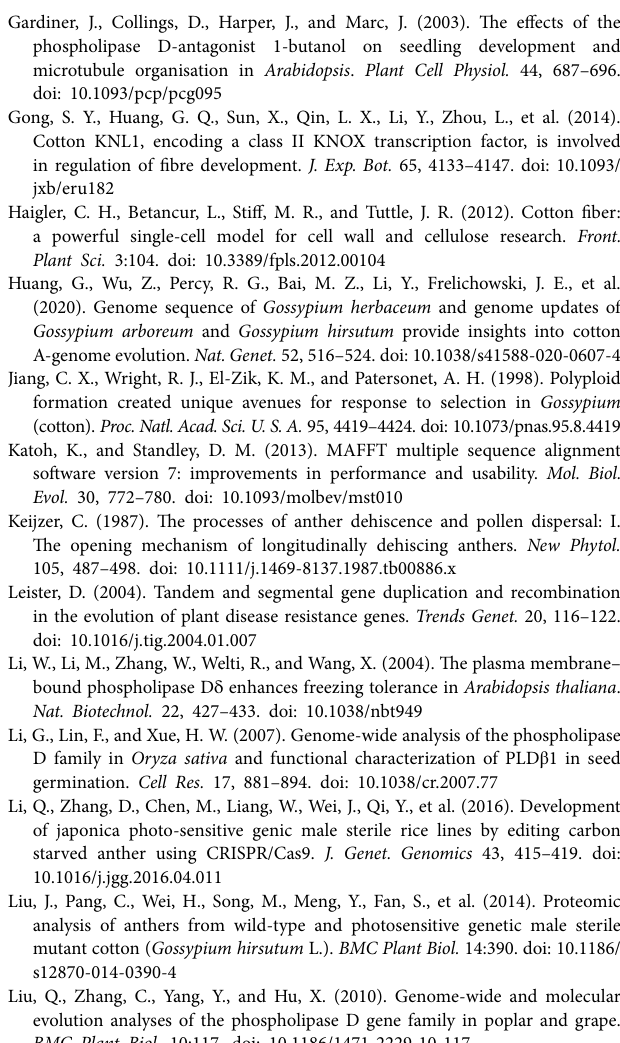
biological repeats. The values are presented as the mean ± SDs of the three replicates. Value of p was calculated based on the Student’s t -tests. Supplementary Figure S5 | Differential expression profiles of the GhPLD s in W10 (WT) and psm5 . The first stage A is a binuclear period of the microspore, the early flowering stage (flower bud length, ~10 mm). The second stage B is 1 day before flowering. The values are presented as the mean ± SDs of three replicates. Values of p were calculated using the Student’s t -tests. ** denotes significance at p < 0.01 as compared to the WT. The details of the primer sequences are listed in Supplementary Table S3 . Supplementary Figure S6 | Re-validation of subcellular localization of GhPLD2 in tobacco ( Nicotiana benthamiana ) leaves. The results in Figure 3 were re-confirmed using the lipid dye FM4-64 (Marker) which labels the cell membranes. Scale bar = 50 μ m. Supplementary Figure S7 | Model of GhPLD2 regulating anther dehiscence and fiber development in cotton. To visually present the function of the GhPLD2 gene, a model depicting the mechanisms underlying GhPLD2 gene regulation of anther dehiscence, fiber initiation, and fiber elongation was constructed. GhPLD2 positively promotes ROS production to maintain normal anther dehiscence and fiber